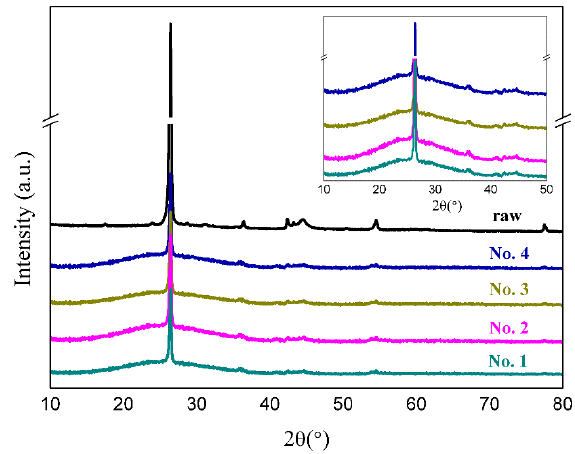
Figure 5. Typical XRD patterns of raw graphite flake and recovered samples.